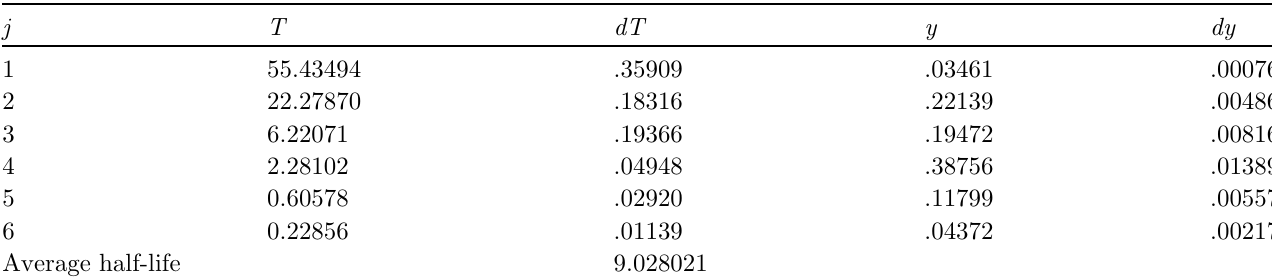
Table A5. Temporal DN parameters in more common form (with absolute dT and normalized a